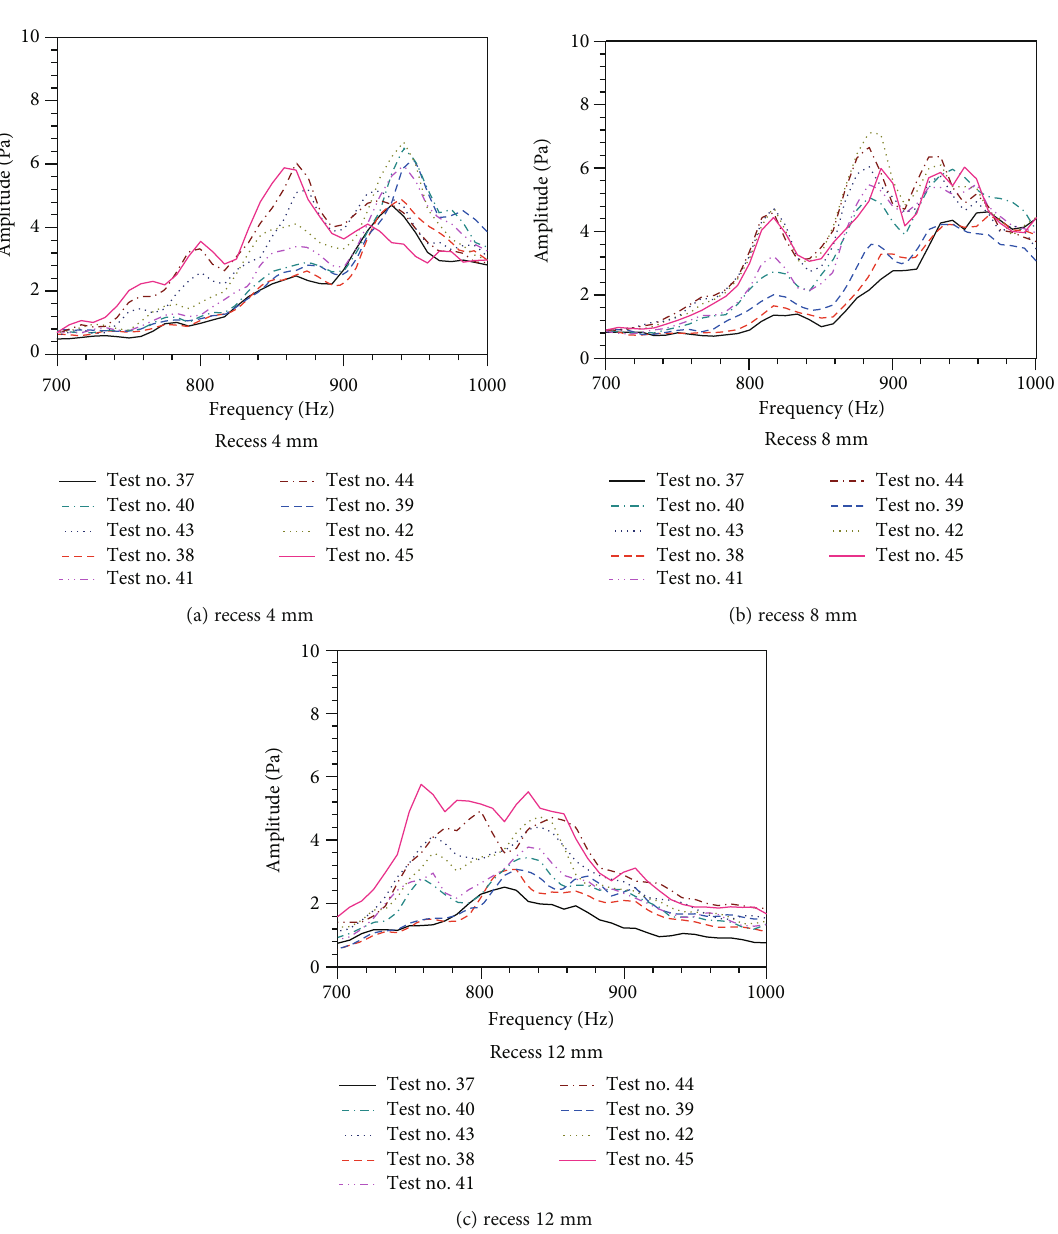
Figure 5: FFT spectrum in set no. 5 (test nos. 37-45) for various recess